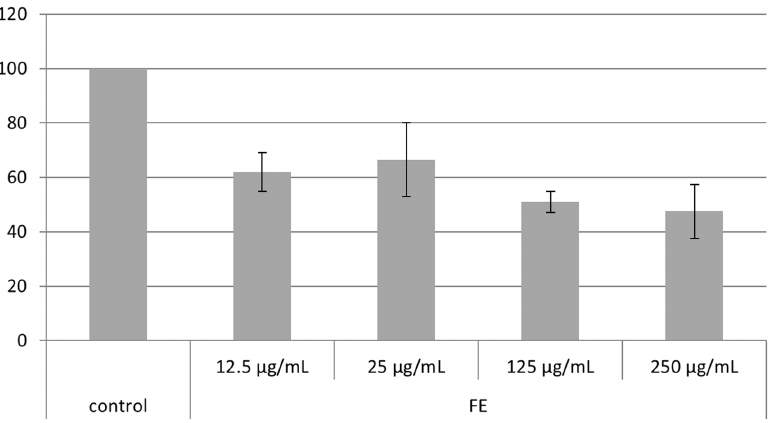
Figure 4. Influence of Okra FE on H.pylori strain 17875/Le b binding to Le b -HSA. Data are related to the Le b -HSA binding of the control (only 17875/Le b together with Le b , =100% Le b binding).